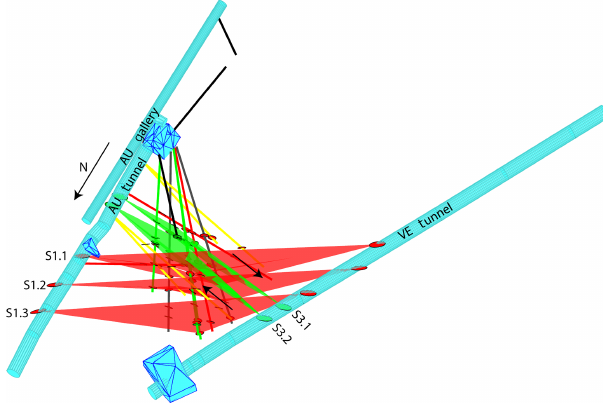
Figure 4. Three-dimensional model showing the boreholes drilled towards the rock volume for the in situ stimulation experiment; S1- (red) and S3- (green) oriented shear zones as well as the dextral shear sense at the S3 shear zones indicated by the black